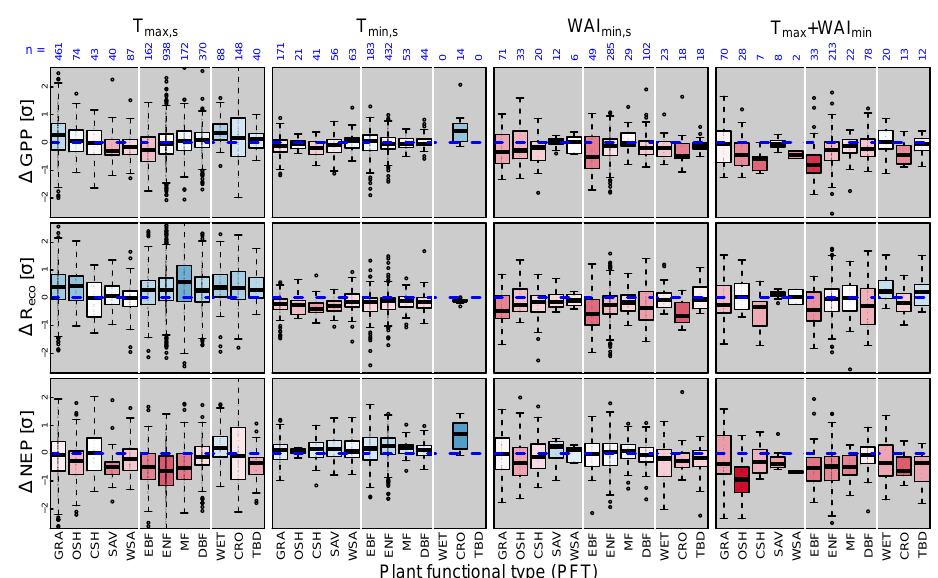
Figure 5. The influence of the ecosystem’s plant functional type (PFT) on the extreme-event impact. Shown are the differences between z -transformed CO 2 fluxes during extreme events and reference periods for the different extreme-event types and the different fluxes ( (cid:49)z = z extr − z ref ; see Eqs. 2 and 3 for details) according to the PFT (see Table A1 for the abbreviations used) of the respective ecosystem (Fig. 4 for a detailed description of the box plots